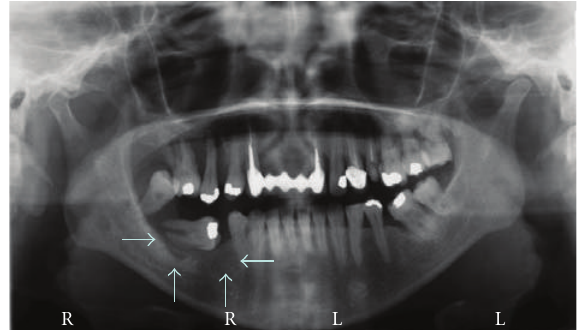
Figure 4: Case 3. Lytic area with displaced floating tooth, right mandible.